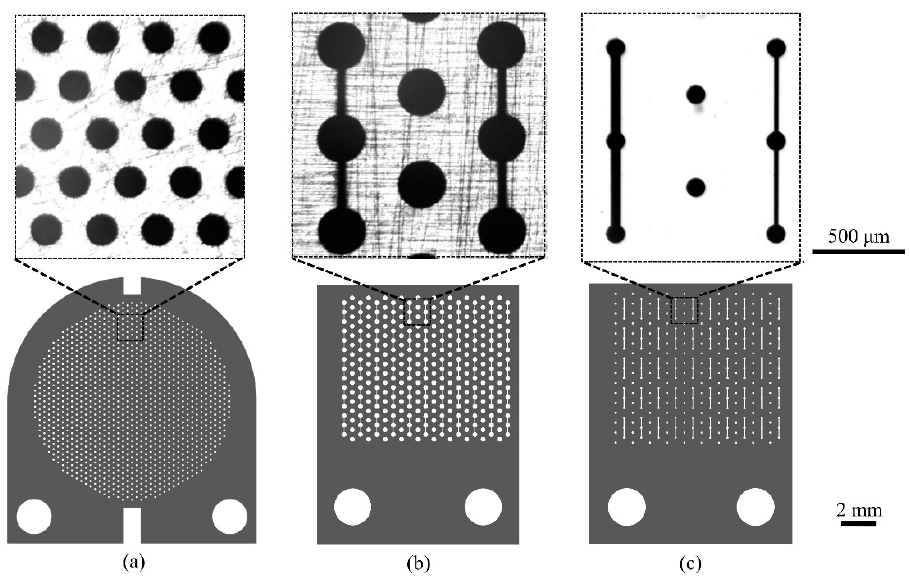
Figure 3. A selection of stencil masks used in this work: design of the mask (bottom) and phase contrast images of details of the pattern (top). ( a ) Stainless-steel mask patterned with dots of diameter 150 µ m, interaxial distance 500 µ m, 150 µ m thin (mask A, Supplementary Table S1). ( b ) Stainless-steel mask patterned with dots and channels. The diameter of the dots is 250 µ m, the interaxial distance is 500 µ m, and the channels are 20 µ m wide. The mask thickness is 50 µ m (mask Q13, Supplementary Table S1). ( c ) Silicon mask patterned with dots and channels. The dots’ diameter is 100 µ m and the interaxial distance is 500 µ m. Alternating lines of dots are connected by 20 or 50 µ m wide channels. The patterned area is 100 µ m thin (mask Q19, see Supplementary Table S1).